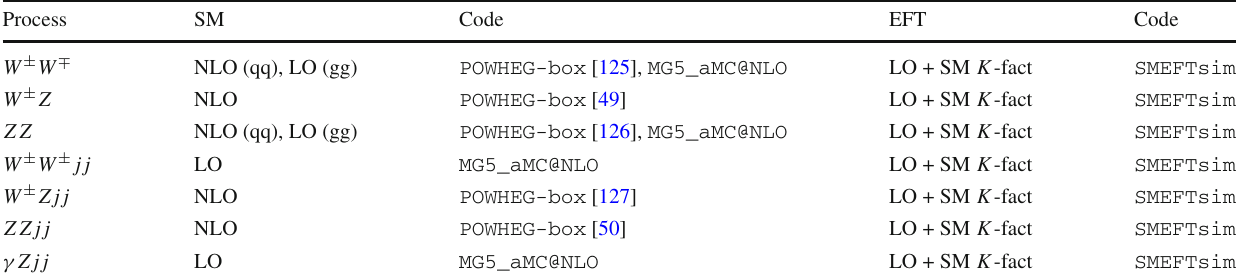
Table4 Thesettingsofthetheoreticalcalculationsusedforthedescrip- tion of the LHC cross-sections included in the present analysis. We indicate, for both the SM and the EFT contributions, the perturbative